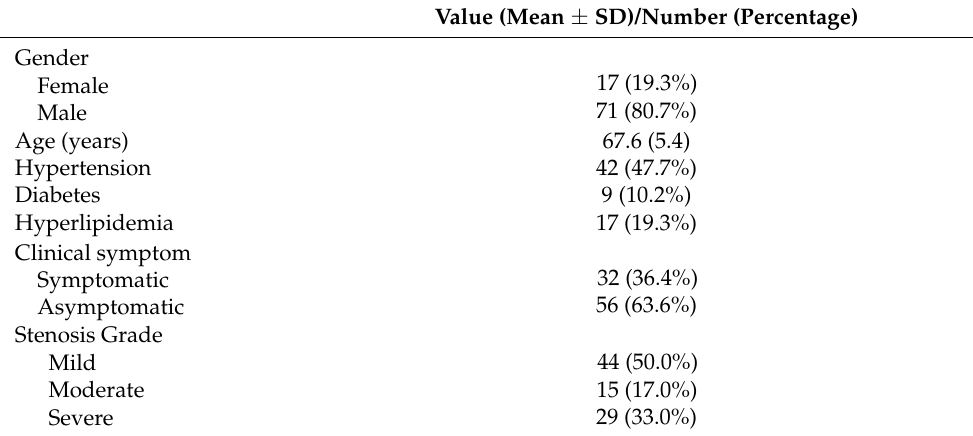
Table 1. Summary characteristics of the